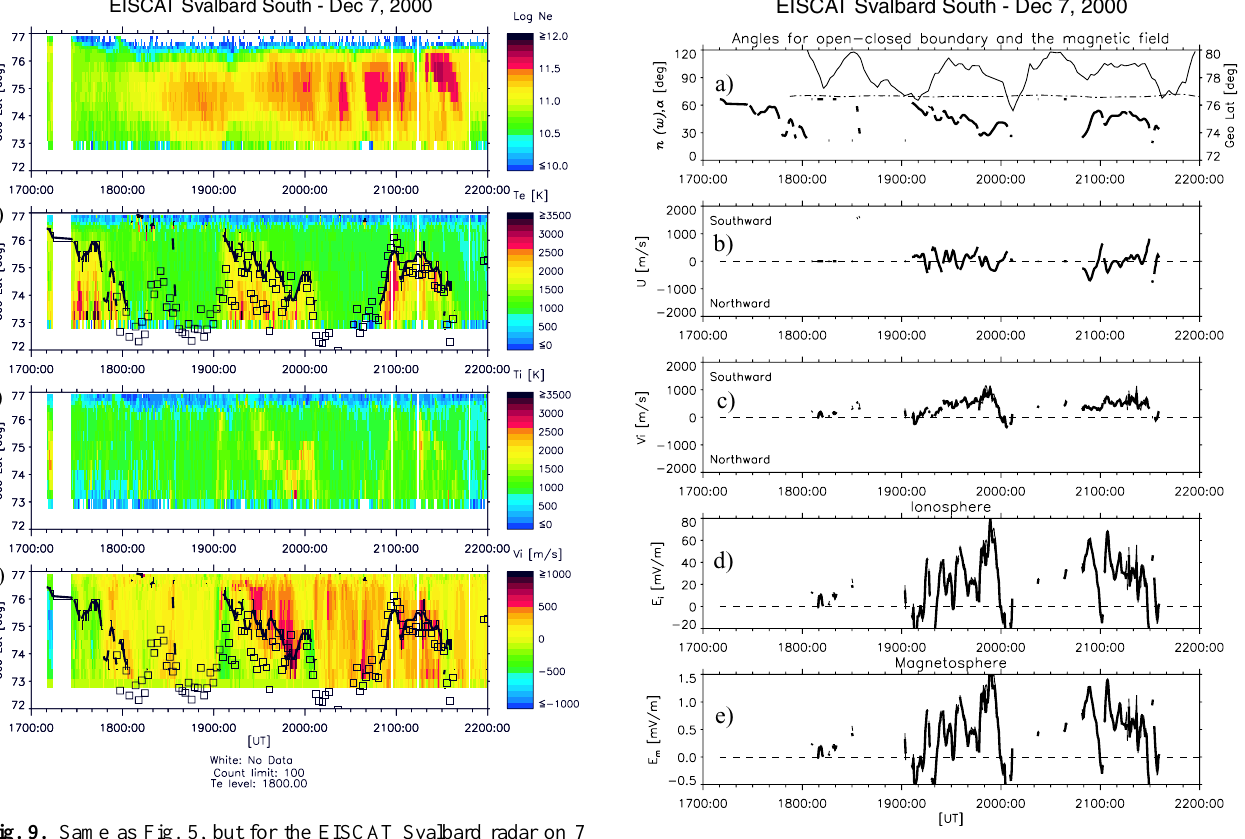
Fig. 10. Same as Fig. 6, but for the South beam. Eq. 9 is used to estimate the maximum ion velocity perpendicular to the boundary and magnetic